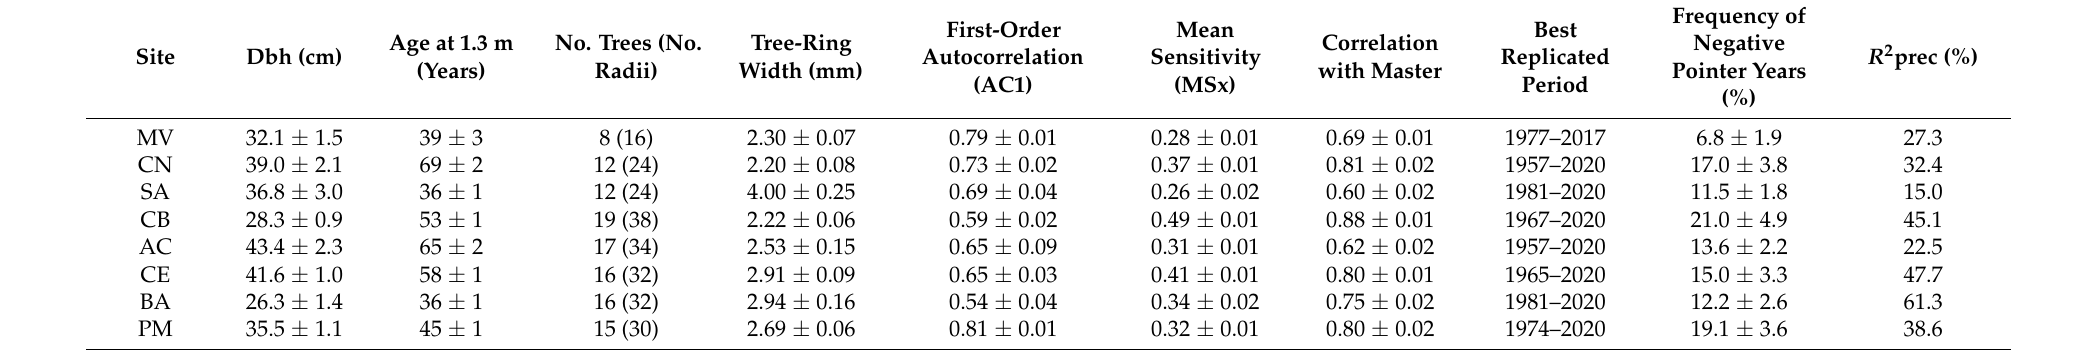
Table 2. Tree size (Dbh, diameter at breast height) and radial-growth values and dendrochronological statistics obtained for the sampled Atlas cedar plantations. Values are means ± SE. The last column shows the percentage of growth variability ( R 2 prec) explained by the precipitation of the hydrological year (prior October to current September) based on a linear regression with the mean site residual chronologies considering the common period 1981–2017. In all cases, the regression coefficients were significant ( p <